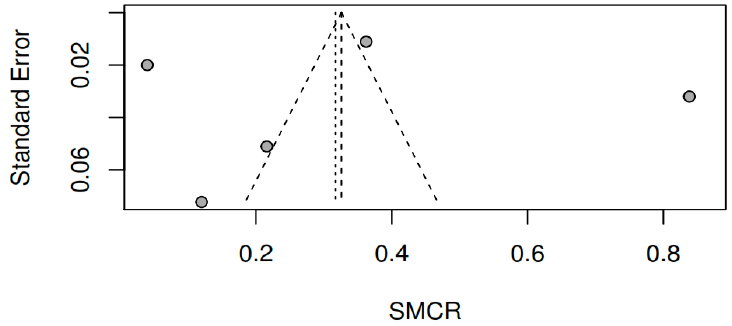
Figure 10. Funnel plot of the positive symptoms variable (pretest–posttest).